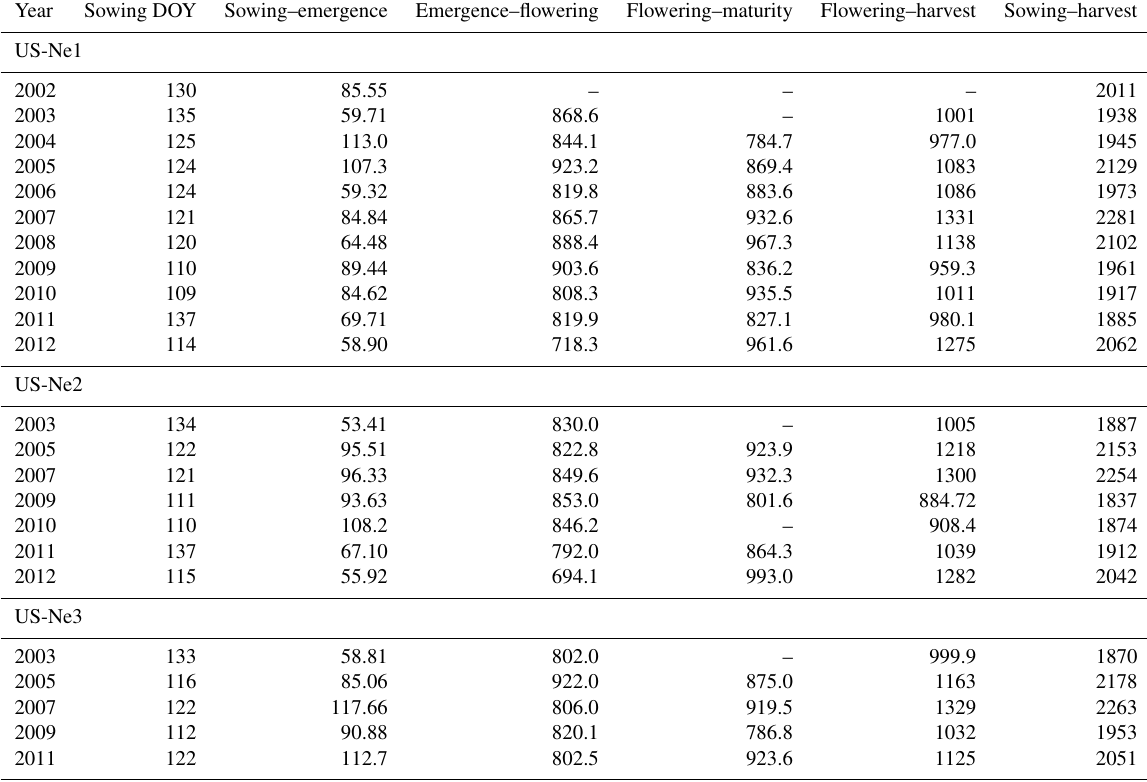
Fig. 13 (centre row) shows the resulting FAPAR distribution against total LAI for a uniform canopy (canopy clumping factor a = 1). For mostly direct radiation (diffuse radiation fraction 0.2–0.3), the rate of decay with layer LAI in the model shows a clear dependence on the zenith angle (Fig. 13, centre right), whereas for mostly diffuse radiation (diffuse radiation fraction 0.8–0.9), this zenith angle dependence is greatly reduced (Fig. 13, centre left). While the observations (Fig. 13, top row) also show a strong zenith angle dependence as the fraction of diffuse radiation decreases, the observations are, in general, consistent with a much lower effective